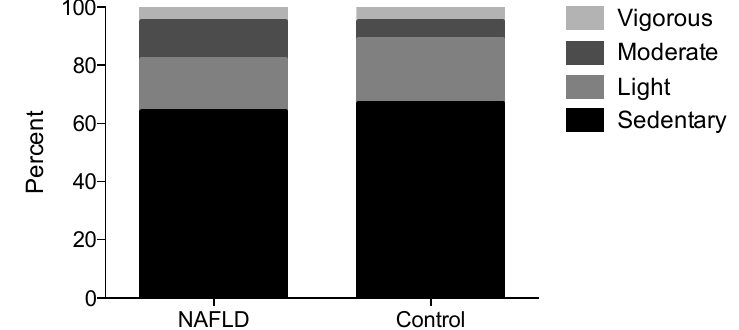
Figure 3. Physical activity levels expressed as amount of time per week (%) calculated using the Youth or Children’s Physical Activity Questionnaire. Data are expressed as percent time per week. NAFLD ( n = 16) Control ( n = 8).